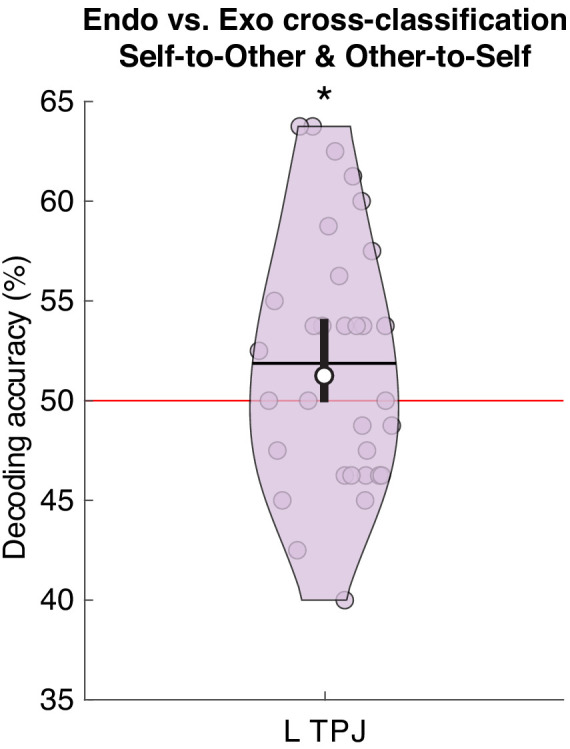
Decoding of attention type generalizes across self-stories and other-stories.Violin plot showing the mean (black horizontal line) and median (white circle) decoding accuracy (%), 95% confidence interval around the mean based on bootstrap distribution (black vertical line), a kernel density estimation (shaded area), and individual data points for a two-way cross-classification analysis based on activity patterns in the left TPJ ROI. The red horizontal line indicates chance decoding. *p<0.05.